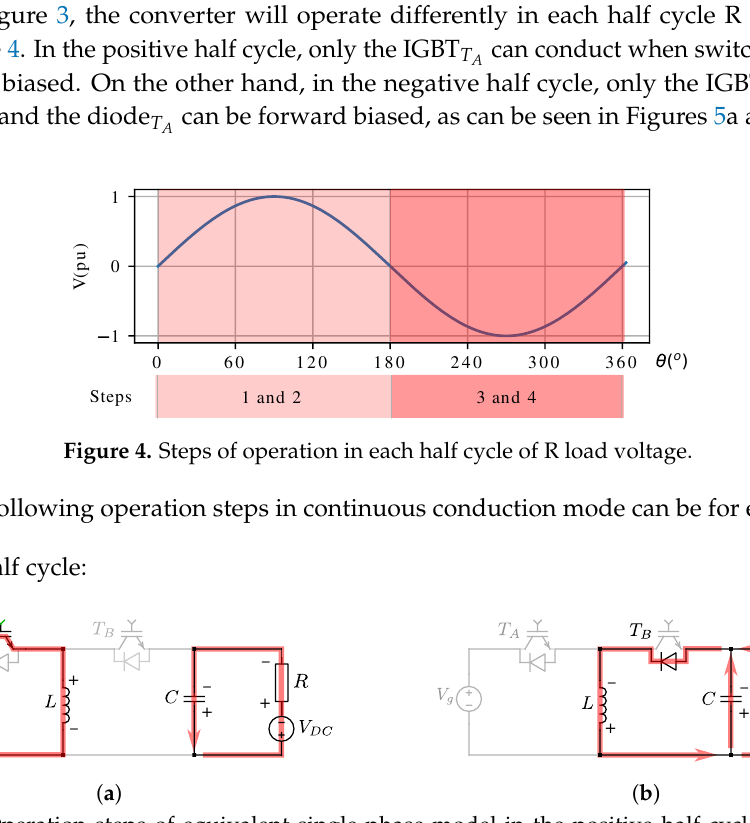
Figure 5. Operation steps of equivalent single-phase model in the positive half cycle: ( a ) Step 1; ( b ) Step 2.